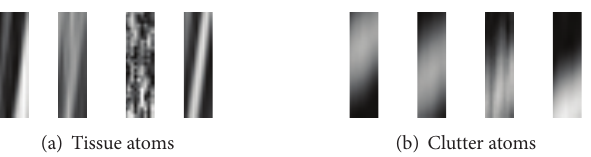
Figure 7: Example of (a) tissue atoms and (b) clutter atoms in the obtained subdictionaries from applying MCA with a cut-off value of 𝛽 = 0 . 75. The dictionary is learned using the simulated sequence echo data. The magnitude of the atoms is presented. The atoms are shown after being transformed from vectors into 2D patches and being envelope-detected. The horizontal direction refers to the temporal dimension and the vertical direction to the axial